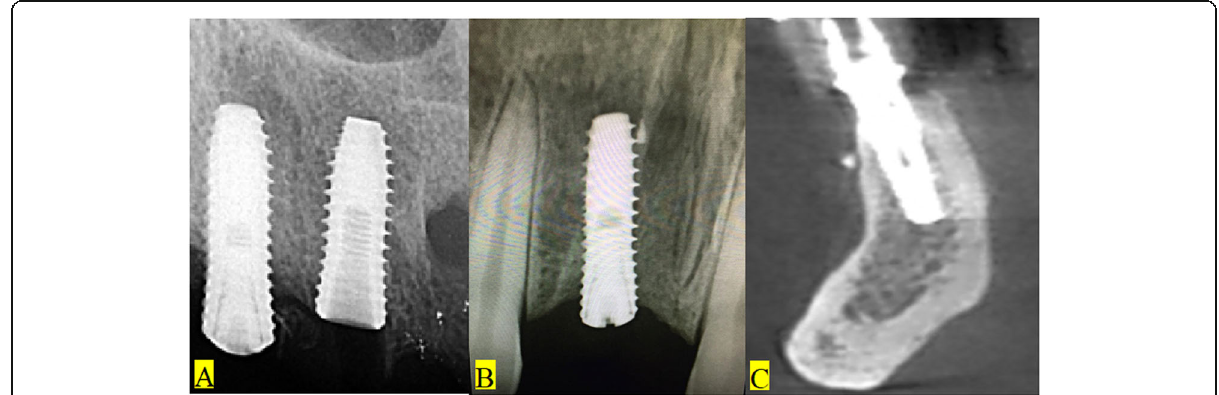
Fig. 3 Different radiopaque forms of endodontic filling remnants were frequently seen related to implant fixtures: a small radiopacities in maxillary